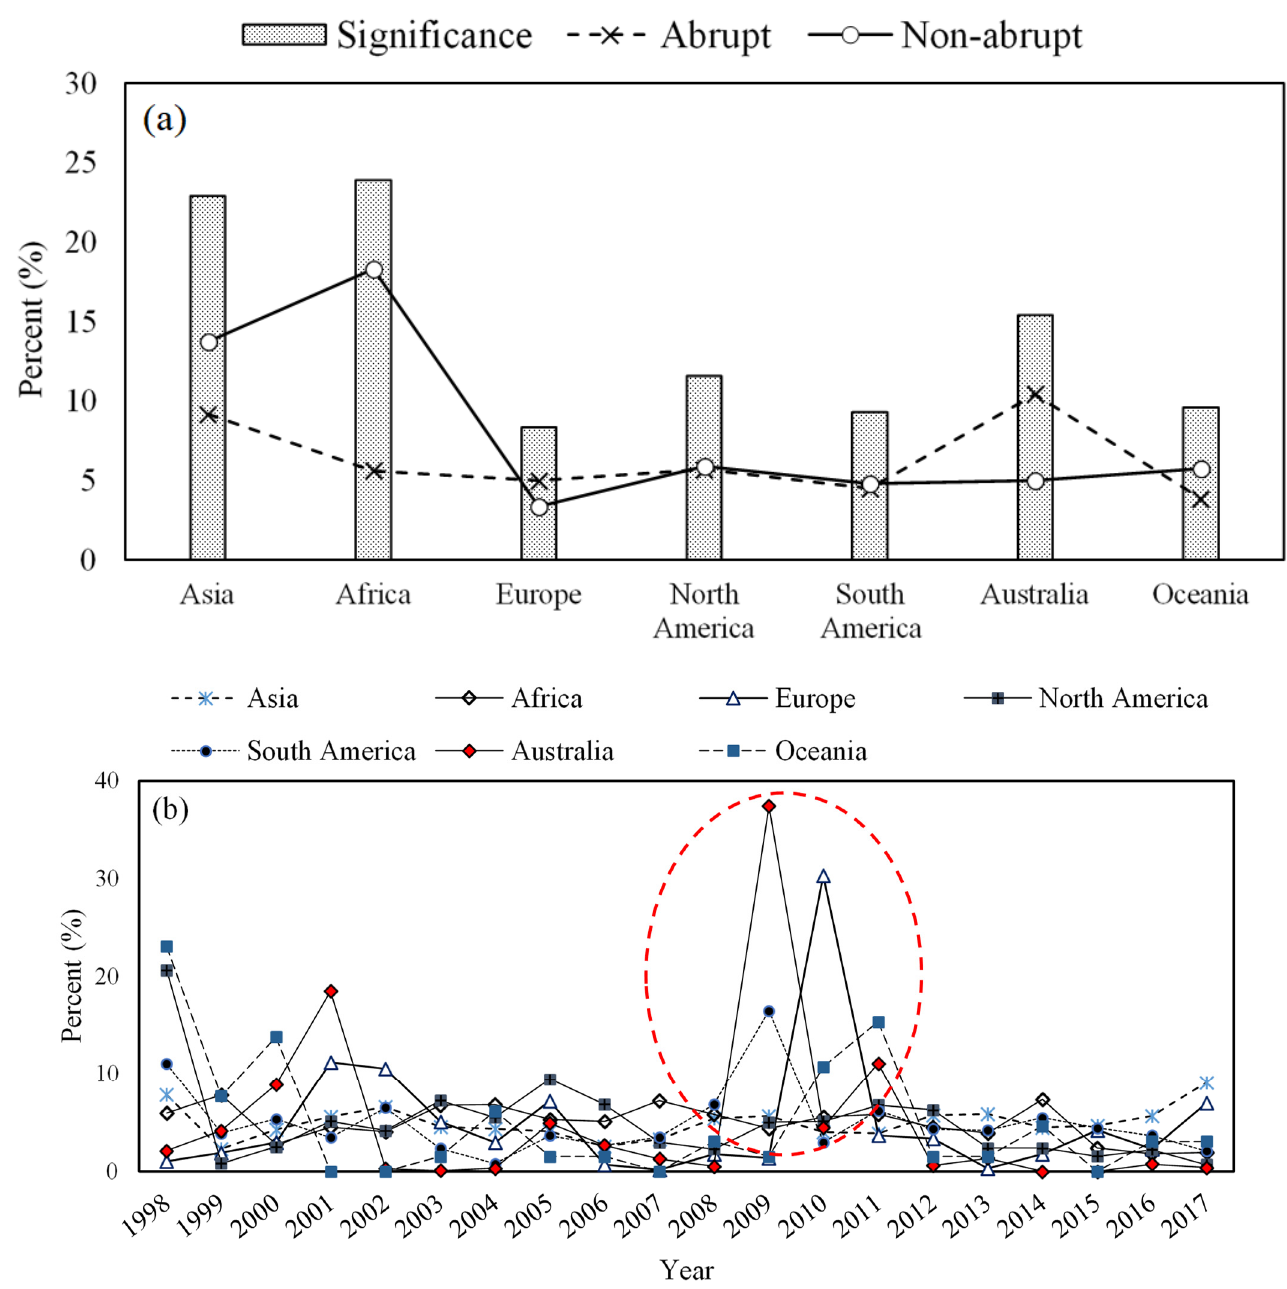
Figure 8. ( a ) Distribution of all significant breakpoints (column) and abrupt and non-abrupt changes (lines) over different continents and ( b ) distribution of all significant breakpoints over the 1998–2019 period.